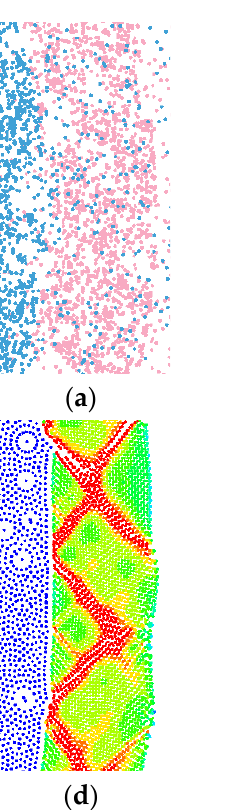
Figure 3. Comparison of the effects of different β values: ( a ) 14.2 μs , β = 0 .8; ( b ) 14.2 μs , β = 1 ; ( c ) 14.2 μs , β = 2 ; ( d ) 14.2 μs , β = 3 ; ( e ) 14.2 μs , β = 7 ; ( f ) 14.2 μs , β = 1 0.